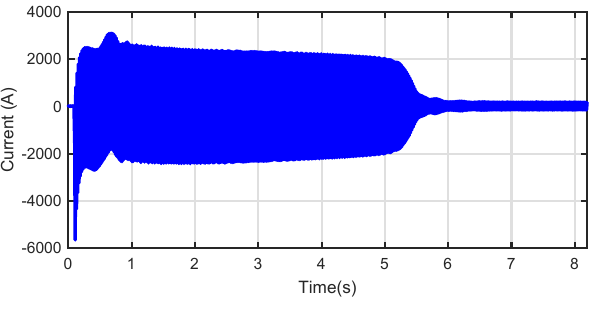
Figure 10. Rotor of the high-power, high-voltage IM given in Appendix B ( left ) and the detail of the broken rotor bar ( right ), used in the experimental validation of the proposed method.